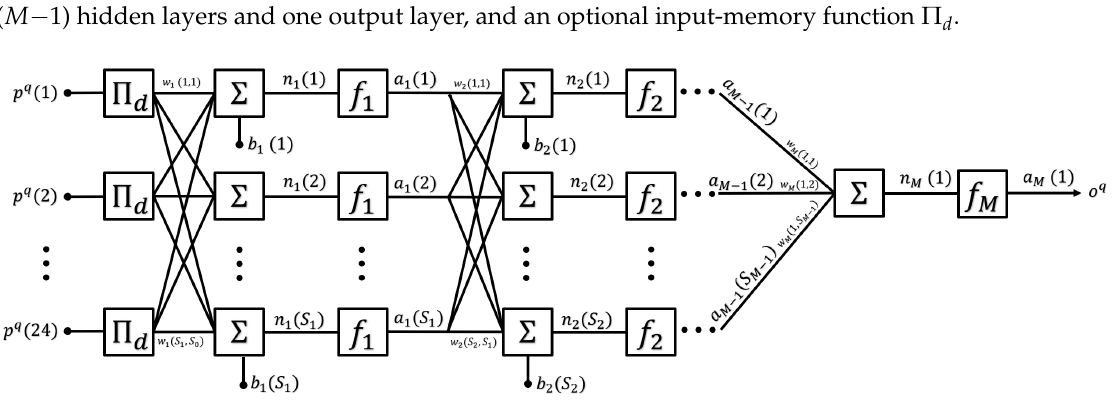
Figure A1. Structure of the M -layer feedforward neural networks used for the prediction of the x and y coordinates of the cylinder